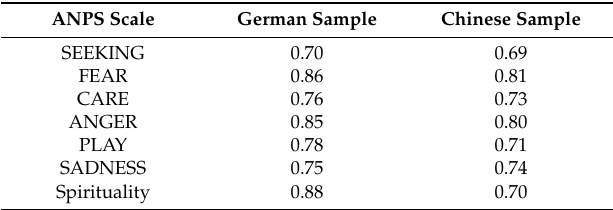
Table 2. Internal consistencies of the ANPS in the German and the Chinese